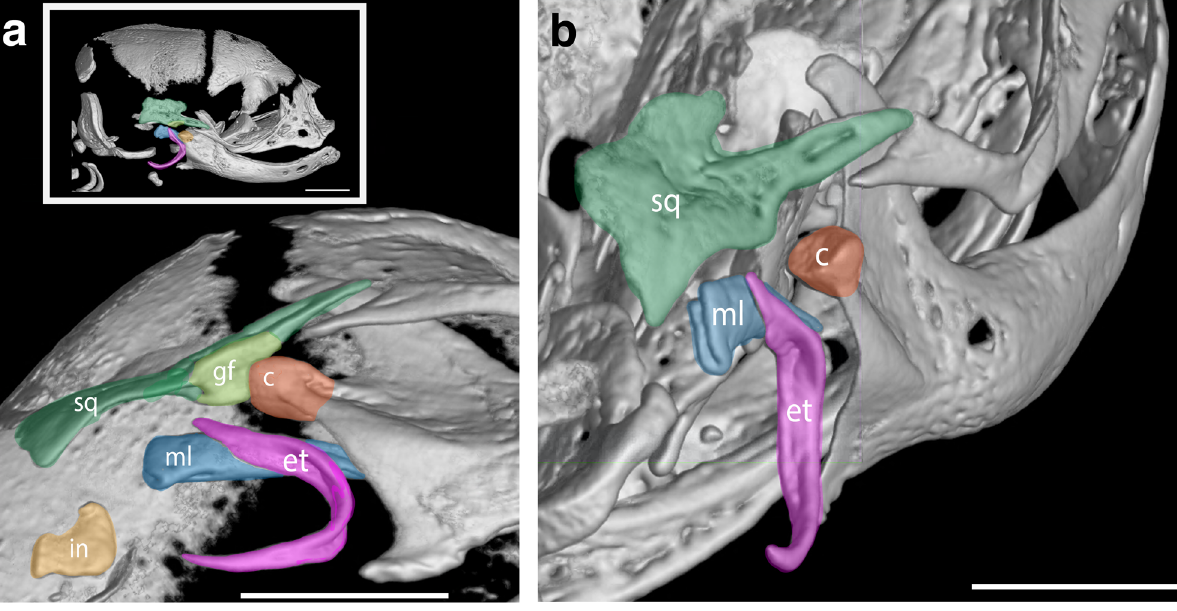
Fig. 6 The secondary jaw joint as revealed in microCT scans in D20 fat-tailed dunnart pouch young. a Ventral view of the secondary jaw joint with inset white box showing entire skull. b Posterior to anterior view of the secondary jaw joint. c = condyle (orange), et = ectotympanic ring (purple), gf = glenoid fossa (light green), in = incus (yellow), ml = malleus (blue) and sq = squamosal (dark green). Scale bar = 1